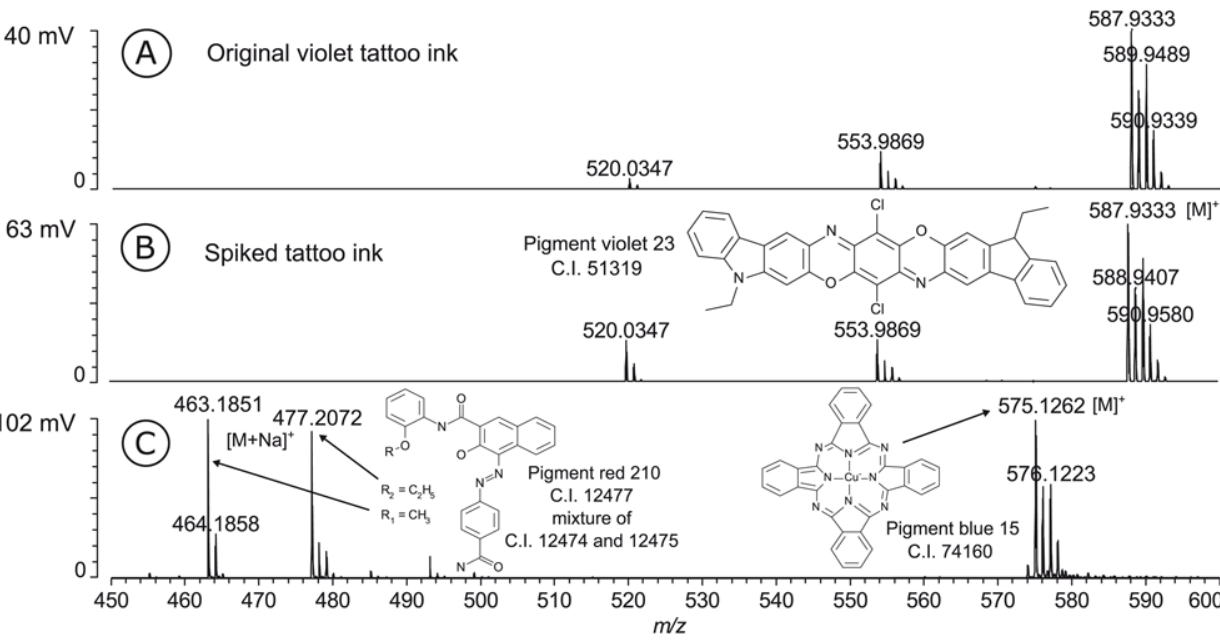
Figure 4. With DHB the signal intensity of the molecular ion [M] + (m/z 628) was twice that of the sodium adduct [M+Na] + (m/z 651), even twelve times as high as without matrix